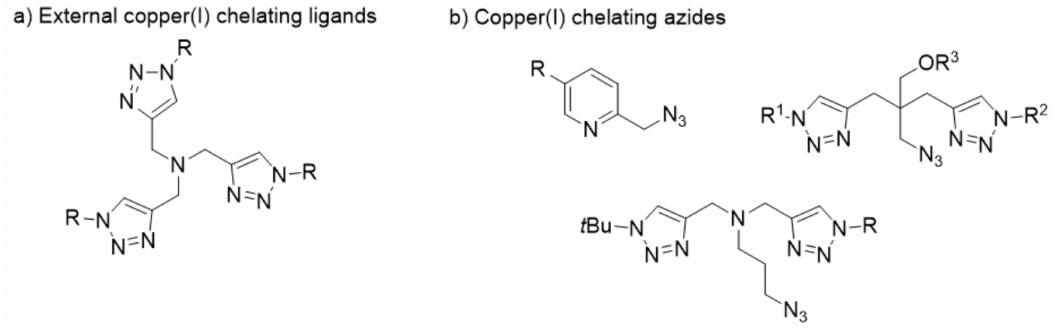
Figure 1. Strategies of copper ligands.